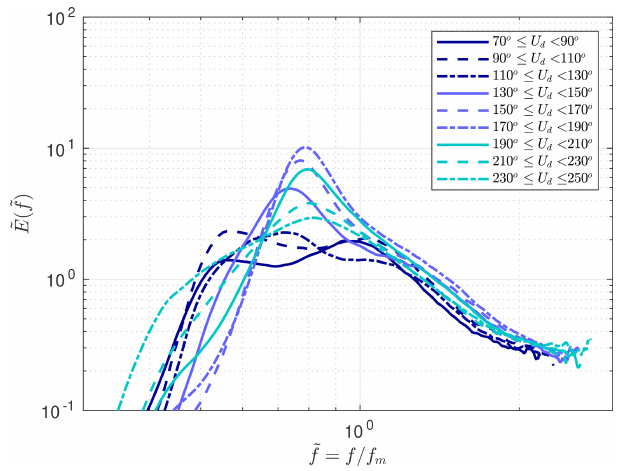
Figure 4. The mean wave spectra at Suomenlinna (T2) as a function of the wind